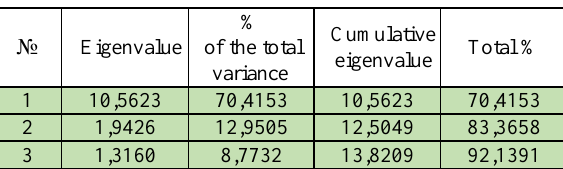
Table 3. Eigenvalues and relative